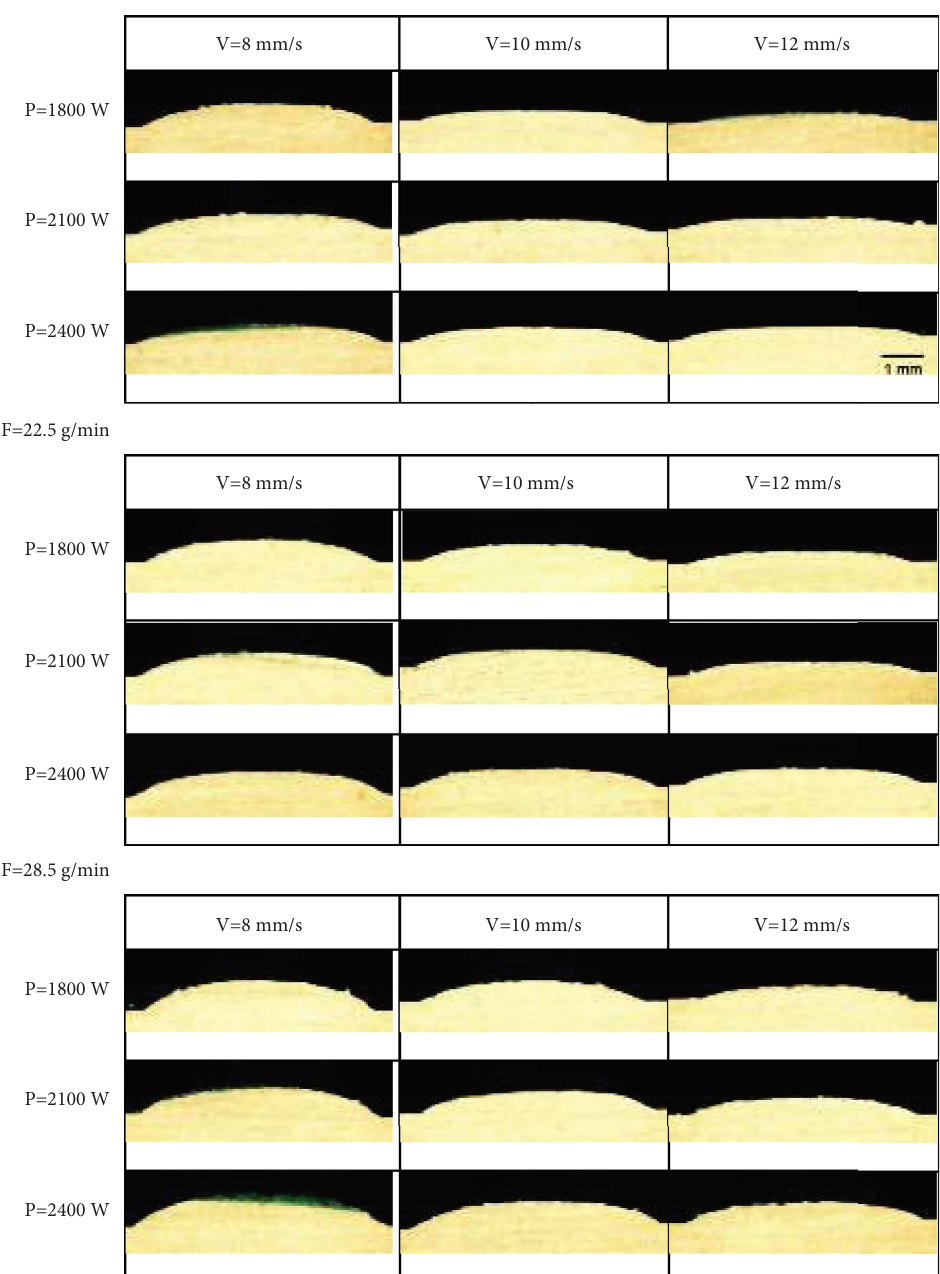
Figure 5: All of the 27 single-track cross-sections. For each powder feed rate (F), the scan speed (V) increases from left to right and the laser power (P) increases from top to